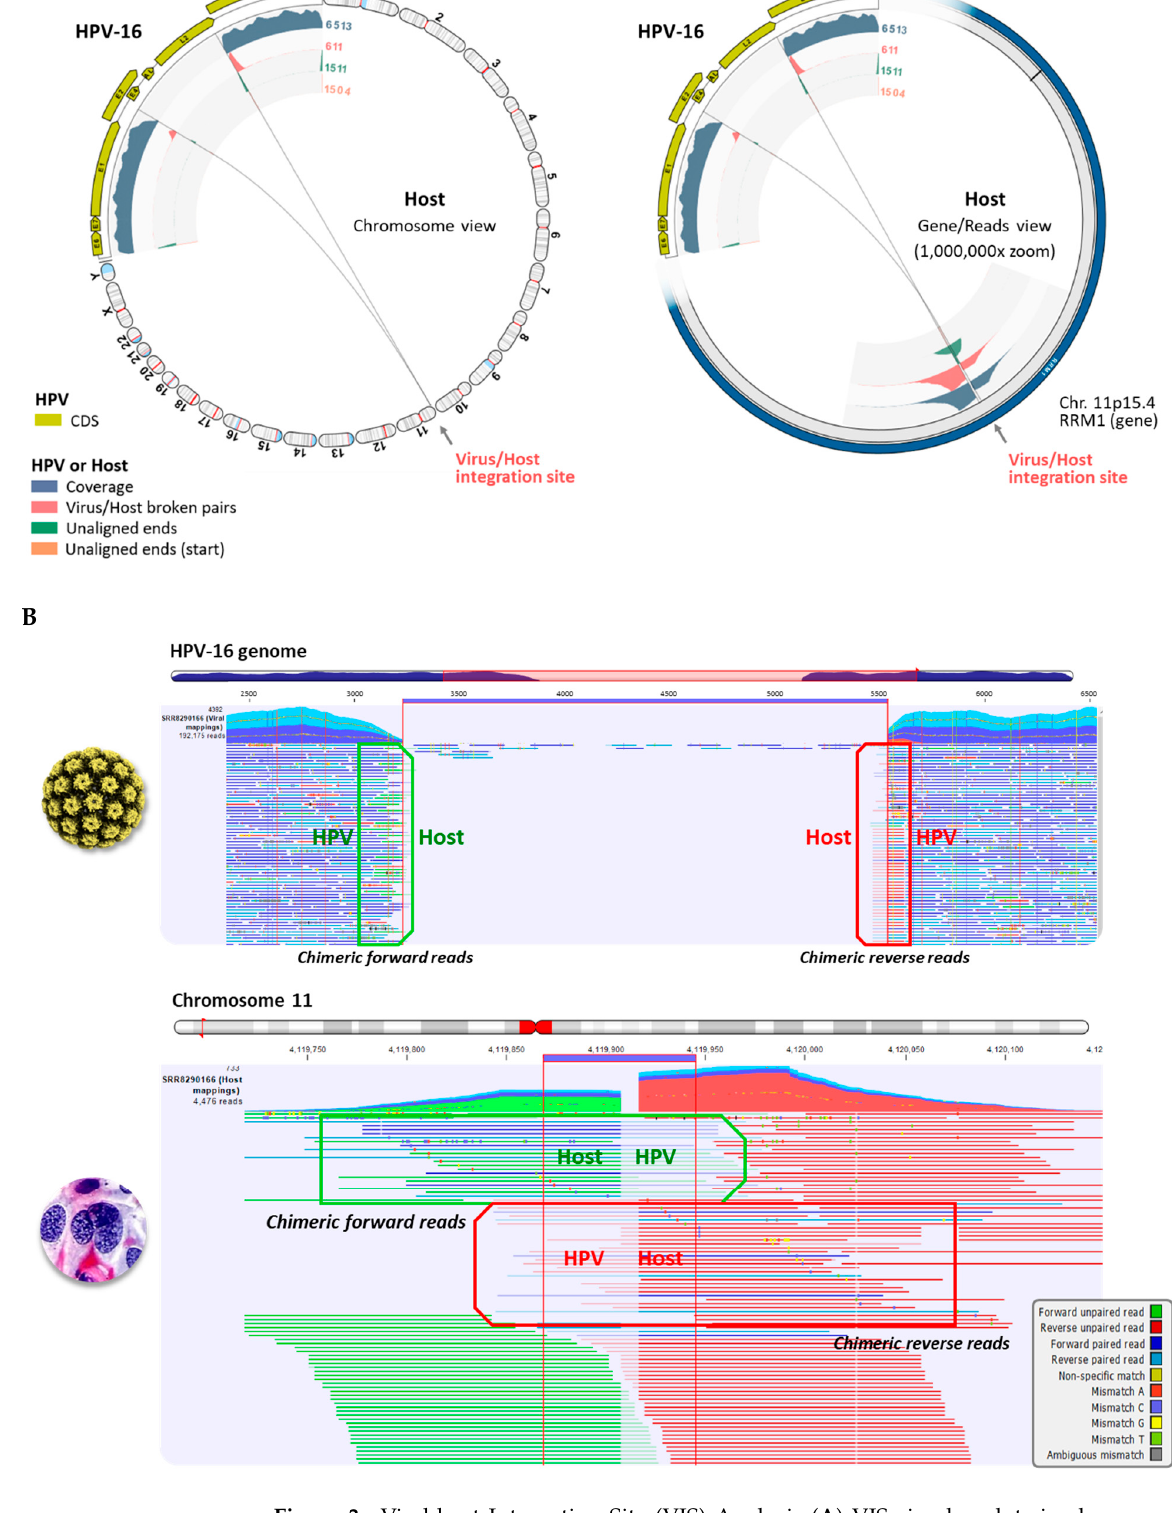
Figure 3. Viral-host Integration Site (VIS) Analysis ( A ) VIS circular plots in chromosome view (left) and gene view (1,000,000× zoom, right) for sample S01; ( B ) Read mapping to HPV-16 and chromosome 11 at sites of broken read-pairs and gaps (thick blue line) reveal forward and reverse viral-host chimeric reads. The mappings are truncated due to the extensive length.